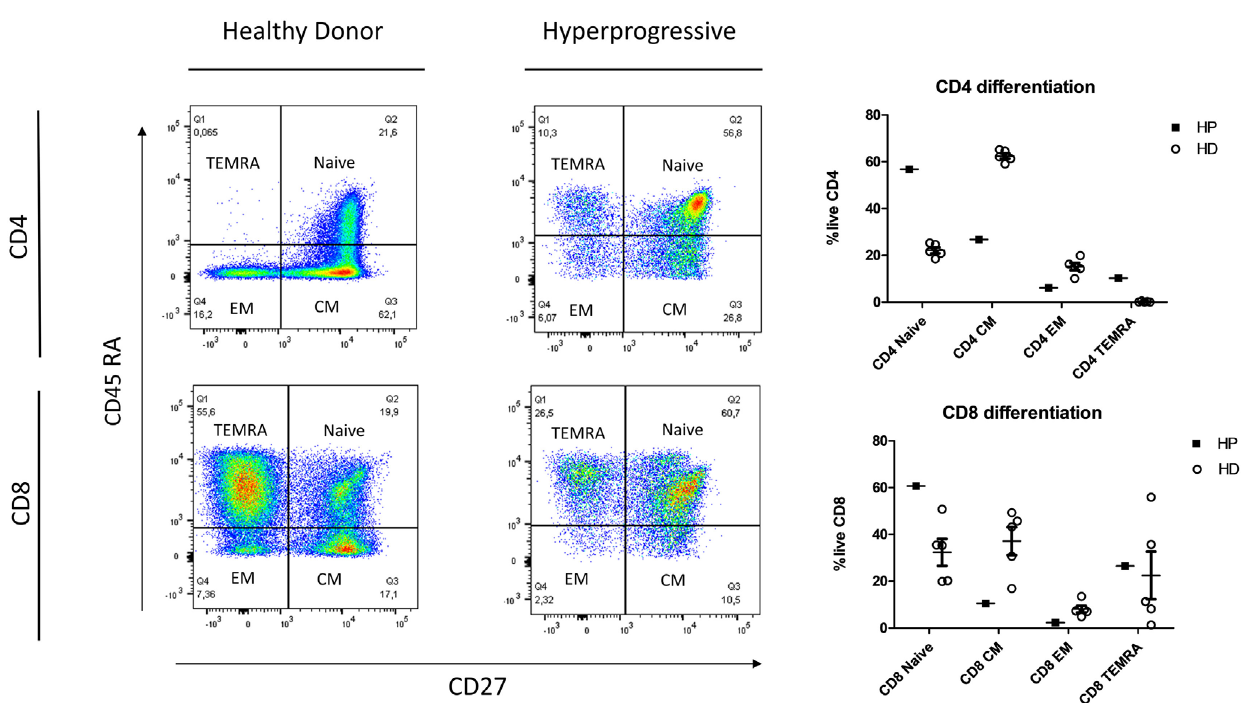
FIgURe 3 | Flow cytometry analysis of lymphoid T cells comparing the HP with five HD. HP showed an increased proportion of naïve CD4/CD8 and CD4 terminally differentiated cells (TEMRA: effector memory CD45RA + ) and a decrease in memory cells (CM/EM). Abbreviations: HP, hyperprogressive patient; HD, healthy donors; CM, central memory; EM, Effector Memory; TEMRA, Terminally differentiated Effector Memory RA + .